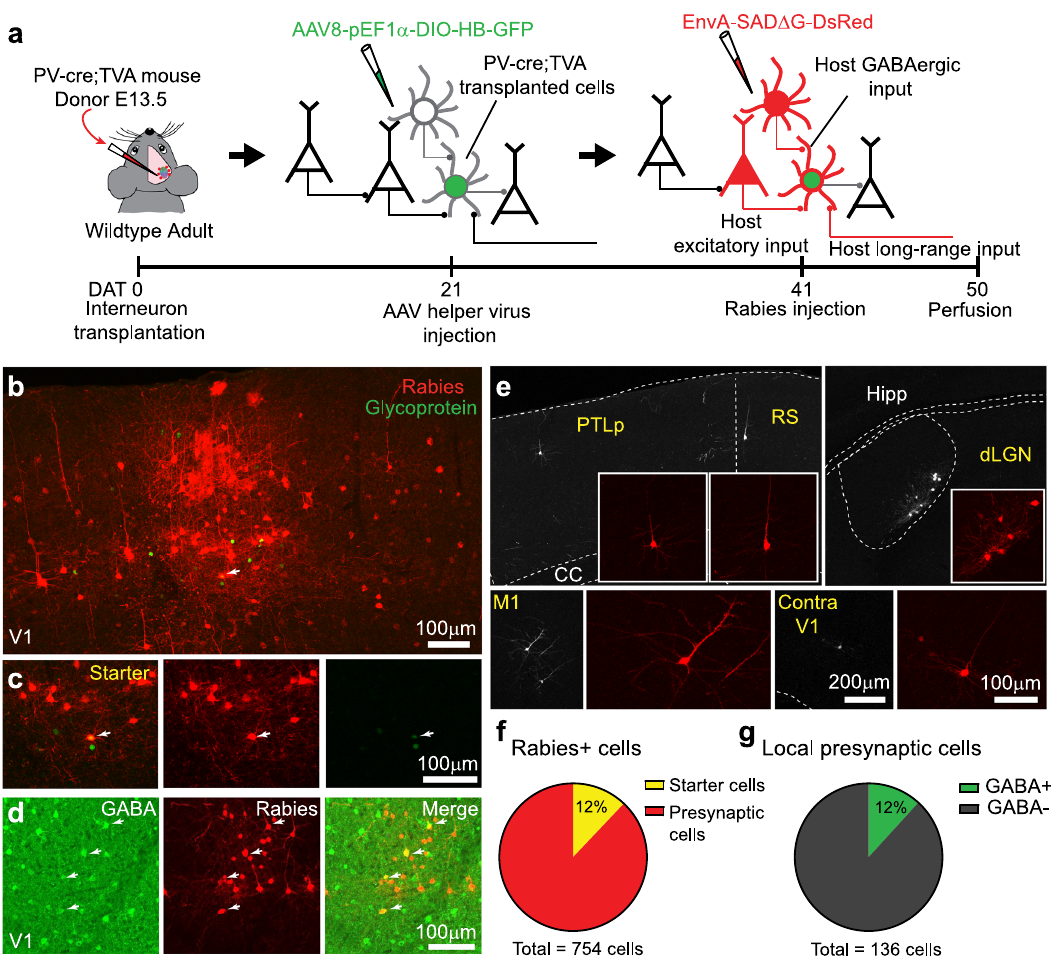
Fig. 2 Transplanted PV interneurons are integrated into the host circuit. a Experimental design. b , c , e Rabies tracing experiments were successfully performed in four transplant recipients. The results were qualitatively similar. The transplanted cells received both local and long-range connections. b Identi fi cation of transplanted starter cells by co-expression of rabies glycoprotein (green) and rabies virus (red). Scale bar = 100 µ m, 50 µ m max projection. c Magni fi ed images of the starter cell in b . Scale bar = 100 µ m, 3 µ m max projection. d Transplanted PV cells received both GABAergic (yellow) and putative excitatory inputs (red) from the host cortex. Scale bar = 100 µ m. Immunostaining of GABA was performed in sections taken from one mouse. Quanti fi cation shown in f and g . e Transplanted PV cells received long-range inputs from various brain regions. Scale bar = 200 µ m, 100 µ m. f Quanti fi cation of transplanted starter cells (total number of rabies + cells counted: 754, number rabies + /GFP + starter cells: 91, and number of rabies + only cells: 663, 1 mouse). g Quanti fi cation of local presynaptic cells that provided inputs to starter transplanted cells (total number of rabies + presynaptic cells: 136, number of GABA + /rabies + cells: 16, number of GABA-/rabies + cells: 120, 1